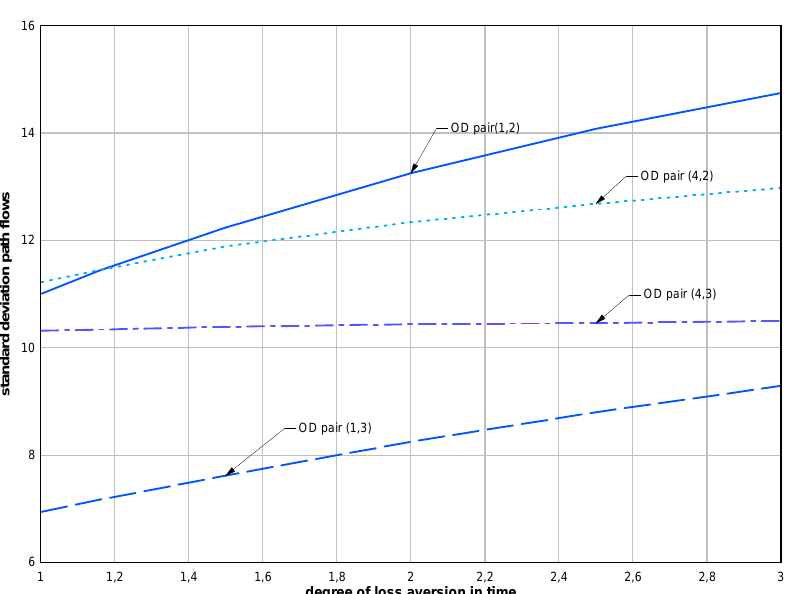
Figure 5. Variation of standard deviation of path flows with degree of loss aversion in the time attribute